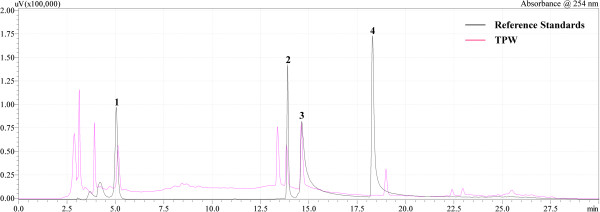
Analytical HPLC-chromatogram of an aqueous bark extract of Terminalia paniculata at 254 nm. (1) Gallic acid; (2) Rutin; (3) Ellagic acid; (4) Quercetin. The chromatographic peaks of the analytes were confirmed by comparing their retention time (Rt) and UV spectra with those of the reference standards (≥ 97% purity).